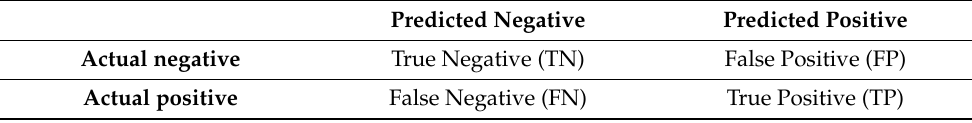
Table 1. Adopted RF confusion matrix to assess the model